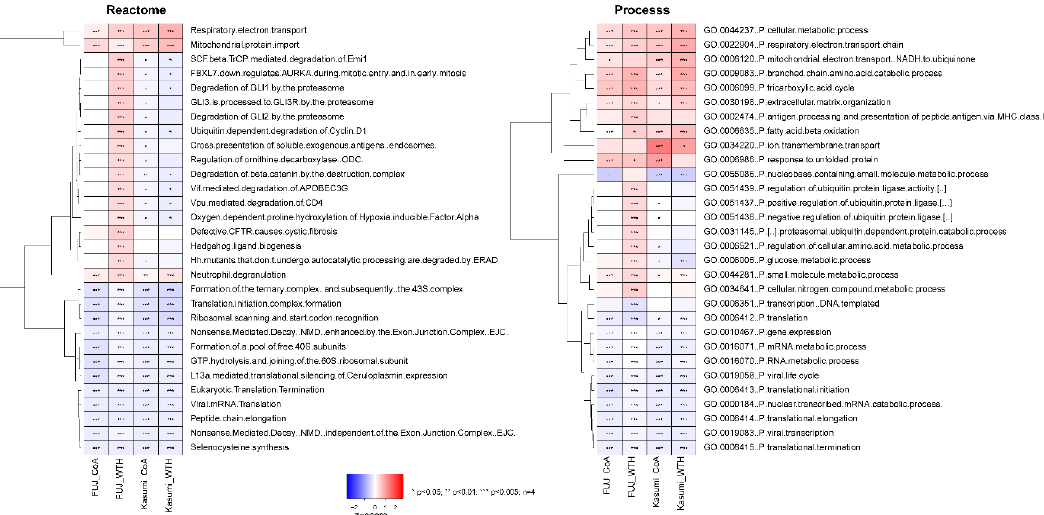
Figure 3. Pathway and ontology analysis of proteins modulated by withanolides. Z-scores and p -values were calculated for the named cell lines and treatment using the parametric analysis of gene expression (PAGE) and Kolmogorov-Smirnoff test, respectively (see Methods for details). To confirm the findings of the ontology and pathway analysis, we performed a targeted analysis of proteins in these ontologies (Figure 4). This analysis confirmed the upregulation of metabolic proteins (Figure 4A–E), including thioredoxin reductase 2 (TRXR2, involved in mitochondrial redox regulation), acetyl-coA aceteyltransferase (THIL, involved in mitochondrial beta-oxidation pathway), isocitrate dehydrogenase (IDHP, gene name IDH2 ), hexokinase 1 (HXK1) and 3-ketoacyl-CoA thiolase (THIM, also involved in beta-oxidation). We also observed a decrease in the expression of several signaling proteins (Figure 4F–J), including the protein kinases PAK2 (Figure 4F) and GSK3A (Figure 4I), which were decreased by both treatments in both cell lines. This targeted analysis also confirmed an effect of the compounds in the ubiquitin-metabolizing proteins (Figure 4P–S). Overall, these data indicate that WTH and CoA induce changes in the expression of proteins involved in regulating key cellular processes including metabolism, signal transduction, protein degradation and gene expression.